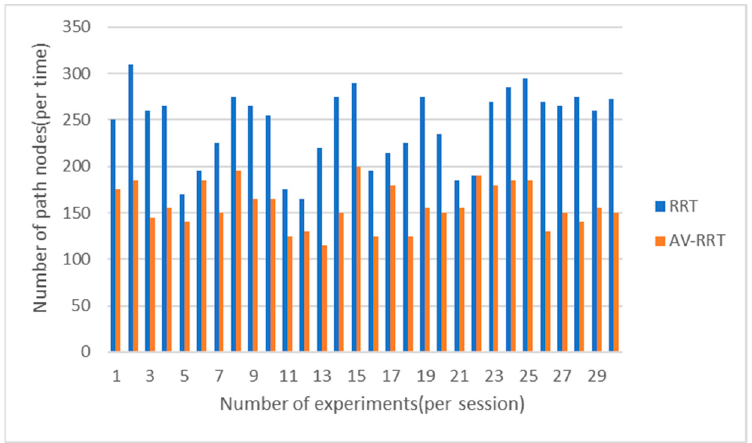
Figure 20. Comparison of the number of path nodes in the scene with dense obstacles.